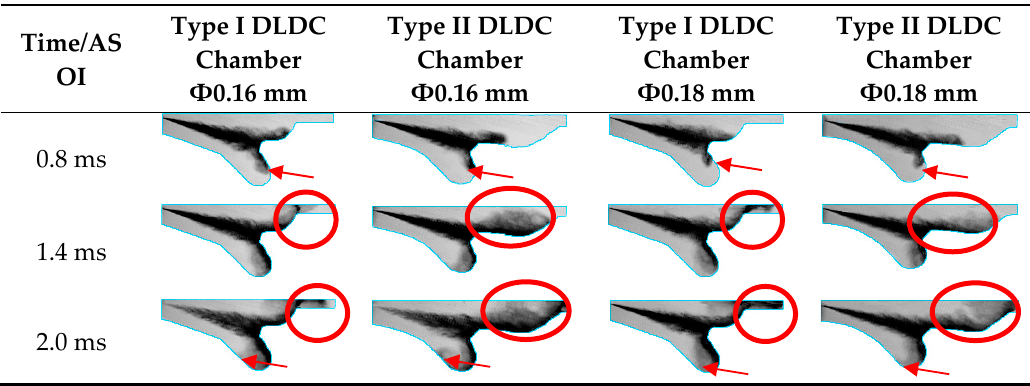
Figure 17. The comparison of fuel spray distributions between the two DLDC chambers with full load, different nozzles, 150 injection pressure and 15 °CA BTDC injection timing of Mode C.